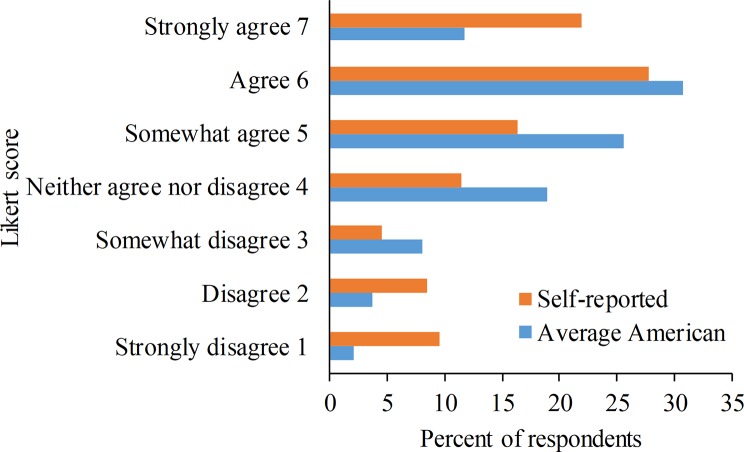
Participant (n = 434) responses regarding willingness to consume products from genetically modified polled cows.Willingness to consume was determined by asking participants “Please tell us how much you agree or disagree with the following statements” followed by questions stating “I am willing to consume food products from cows genetically modified to be hornless” (Self-reported) and “Most Americans are willing to consume food products from cows genetically modified to be hornless” (Average American).